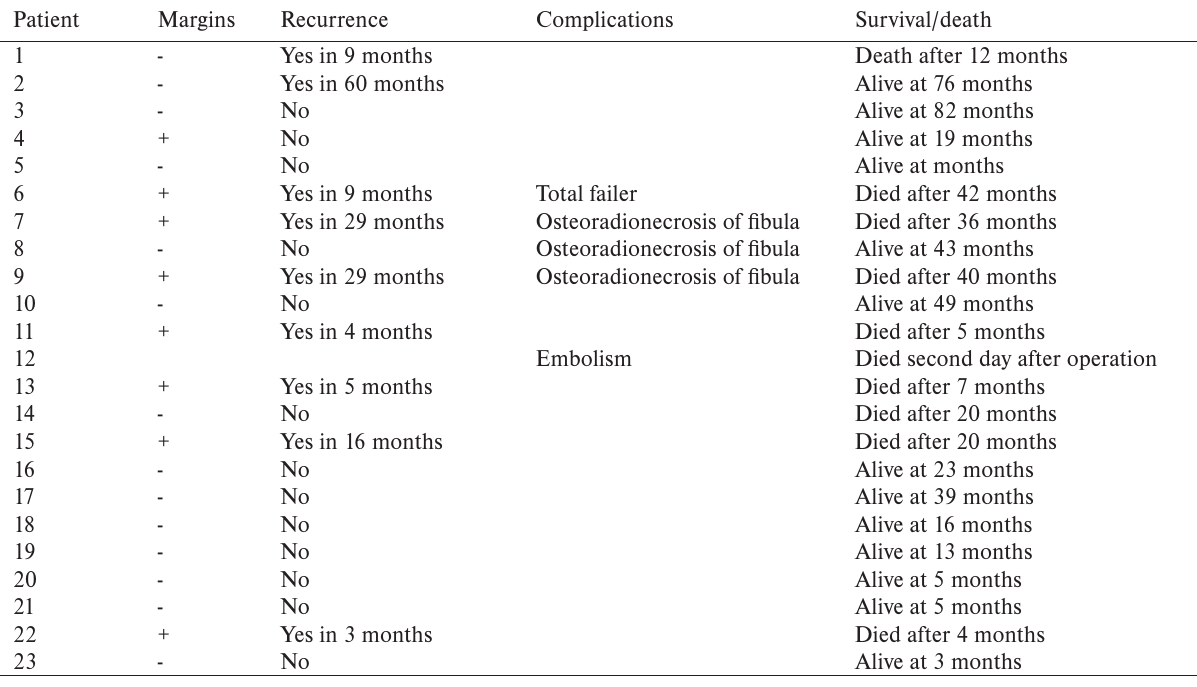
Table 2. Results (recurence, positivity of the margins, complications) of the patients after